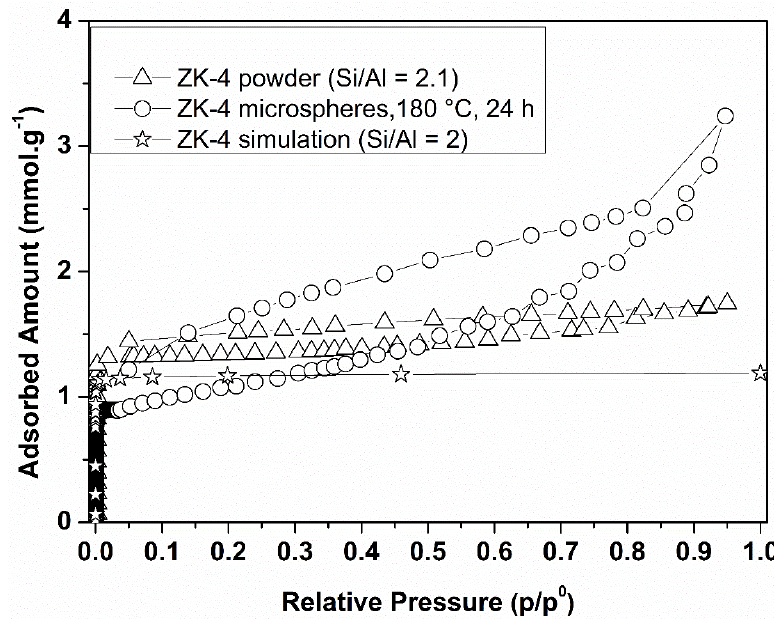
Figure 6. n -Hexane adsorption isotherms done at 25 °C. Molecules 2018 , 23 , x FOR PEER REVIEW